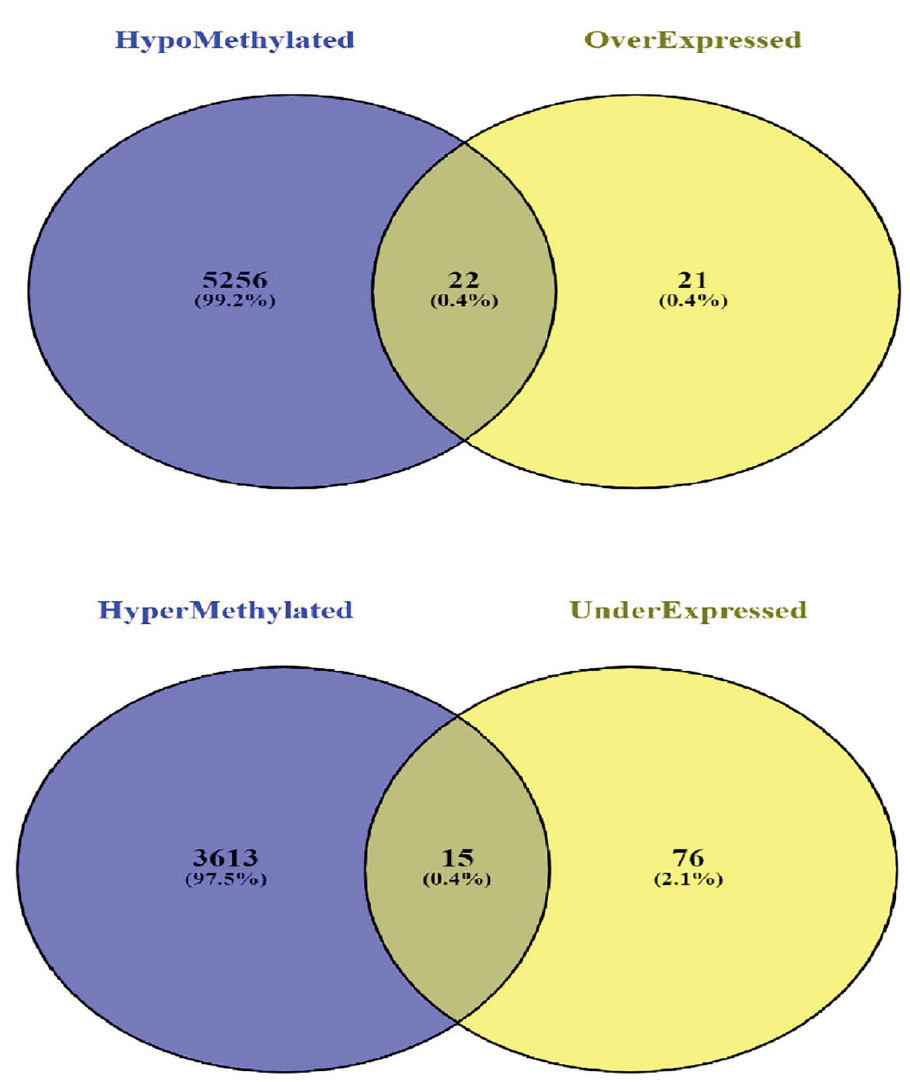
Fig 5. Venn diagram depicting the number of overlapped validated Differentially Expressed Genes-Differentially Methylated Genes (vDEGs-DMGs). Top) Over-expressed/hypo-methylated vDEGs-DMGs. Bottom) Under- expressed/hyper-methylated